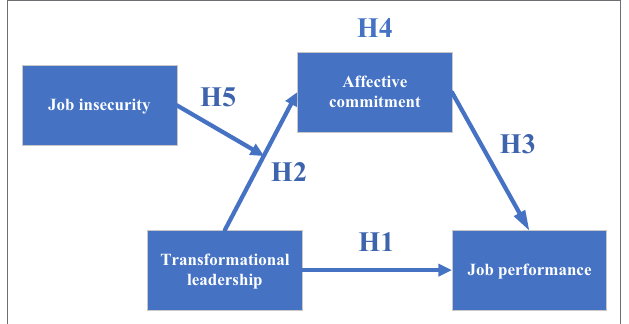
FIGURE 1 | Theoretical model of the